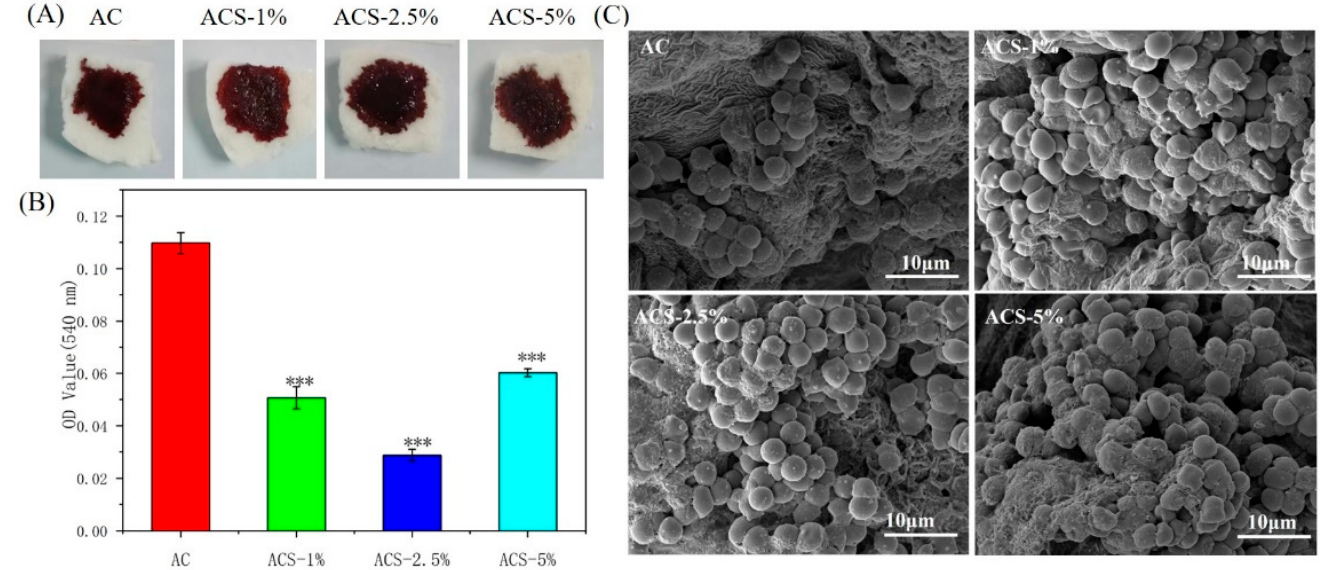
Figure 4. In vitro blood-coagulation test of composite sponges. ( A ) Photographs of the blood-clot- ting process. ( B ) Hemoglobin concentration in water. Data are the mean ± SD for each group (n = 3), * Significant difference from the AC group, *** p < 0.001. ( C ) Scanning electron micrographs of three sponges after coagulation.